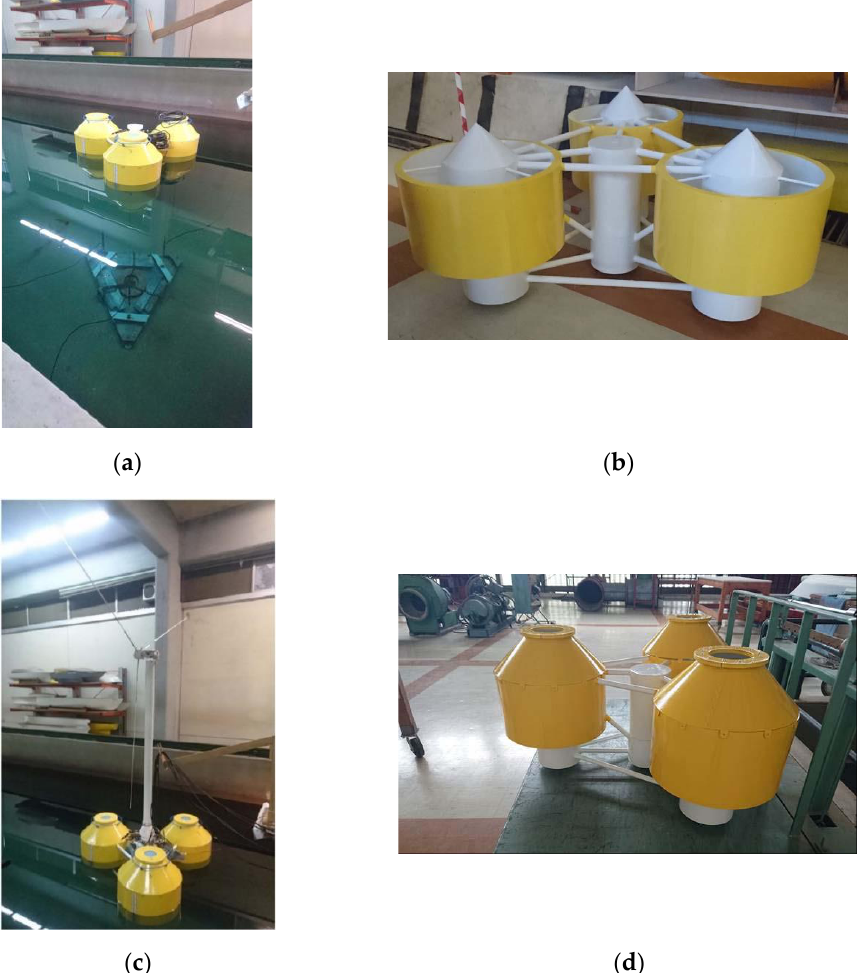
Figure 7. The REFOS 1/60 model: ( a ) base of the TLP mooring system; ( b ) platform buoyant cylinders and OWC walls; ( c ) model in the experimental tank; ( d ) OWC domes outside the